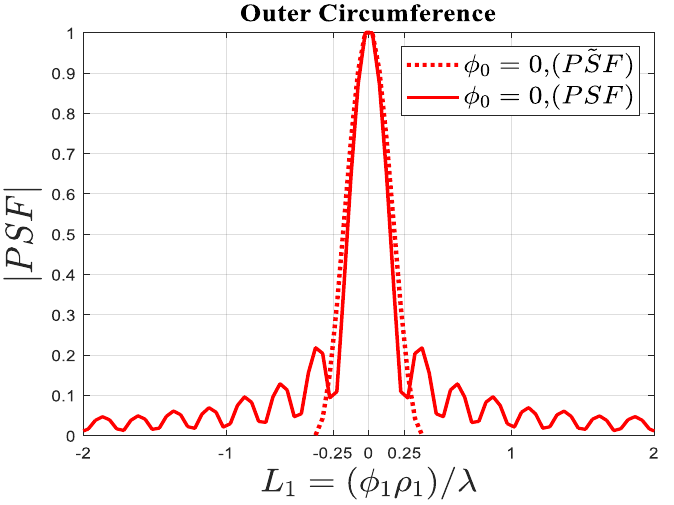
Figure 9. Comparison of the normalized amplitude of the actual PSF and approximated PSF for 𝜙 0 = 0 .